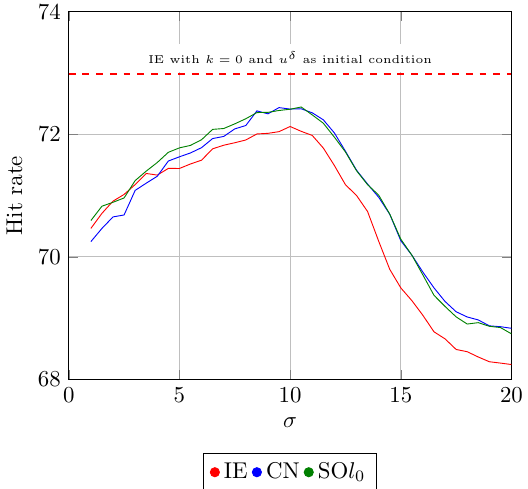
Figure 13. The hit rate of the centaur shape over different widths σ of the Gaussian initial condition. For this, we fixed the damping parameter at k = 0.1. The red solid line denotes the IE method, the blue indicates the CN method and the green line is for the SO l 0 method. The red dashed line shows us the hit rate of the wave equation solved using the IE method and δ -peak initial